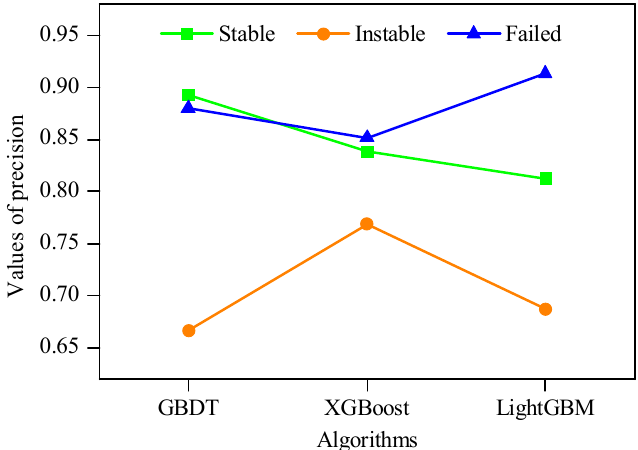
Figure 8. Precision values of algorithms for each stability level.